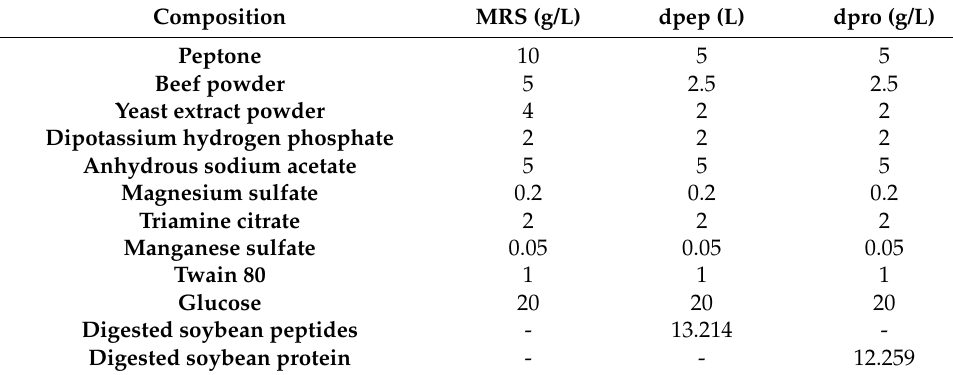
Table 1. Composition and content of medium in different